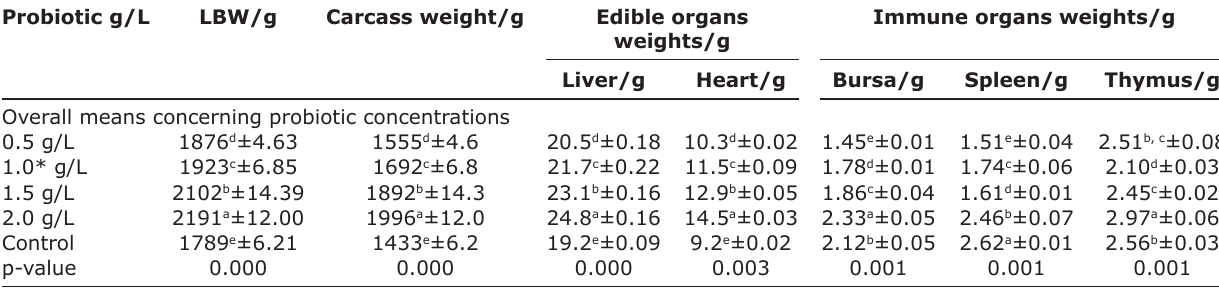
Control p-value